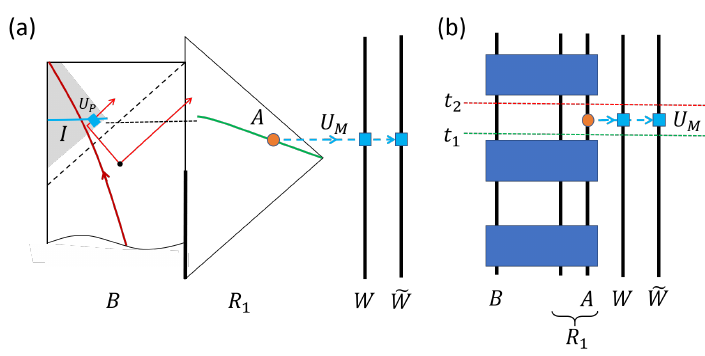
Figure 4 . Illustration of the particular setup in subsection (3.2) in Penrose diagram (a) and quantum circuit (b). We consider two states different by an interior unitary U P , as was discussed in figure 2. In addition, a unitary U M (defined by eq. (3.6) applied to region A and two ancilla qubits W, ˜ W measures A and records the result on W . The green and red horizontal dashed lines indicate the time t 1 before applying U M , and t 2 right after applying U M . What is relevant to our discussion is the application of state reconstruction formula (2.7) for A at time t 1 and W at time t 2